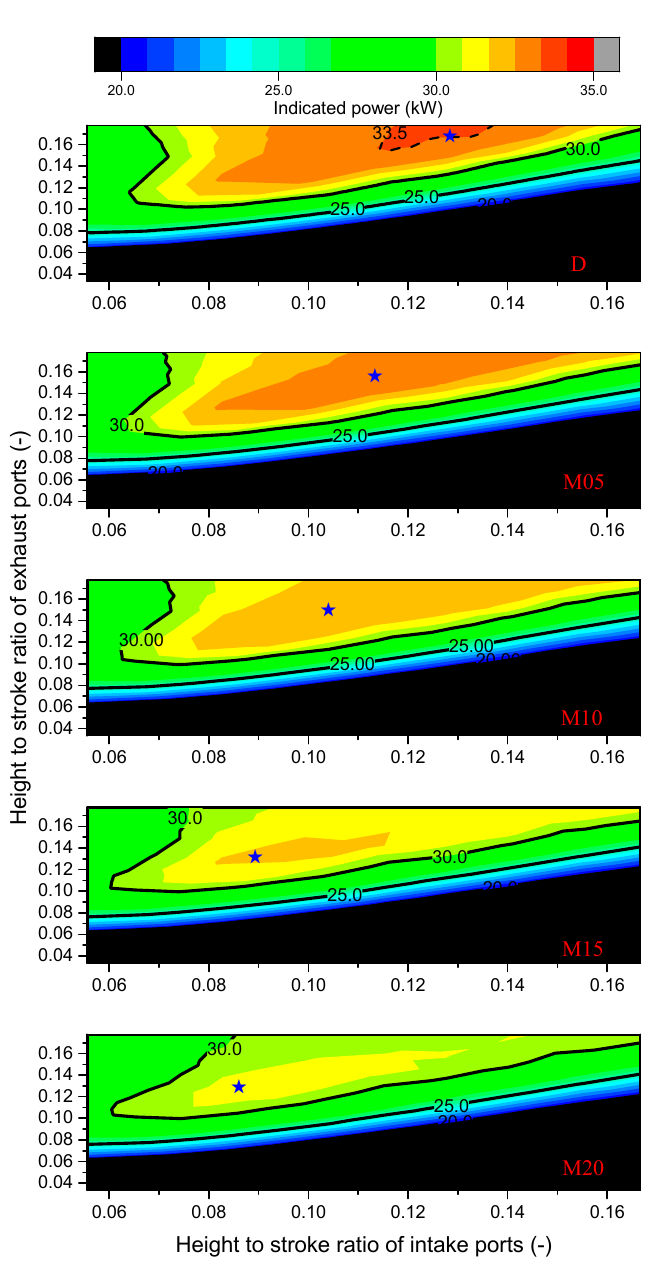
Figure 11. Indicated power under the interaction of the intake and exhaust ports.